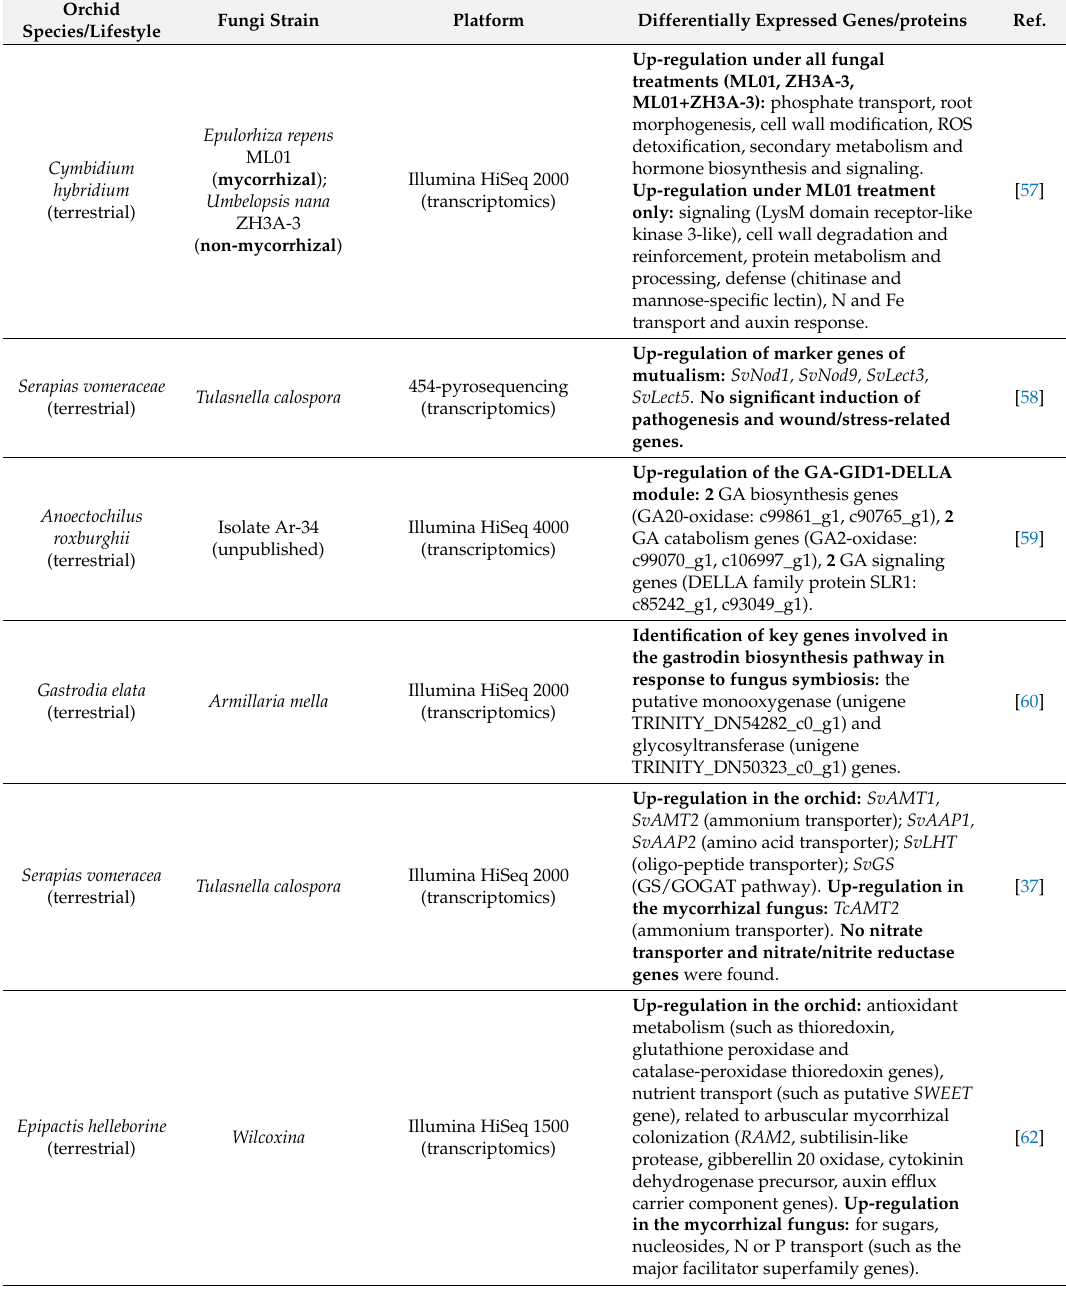
Table 1. Overview of the current studies on the orchid-fungus symbiosis by using transcriptomic and proteomic